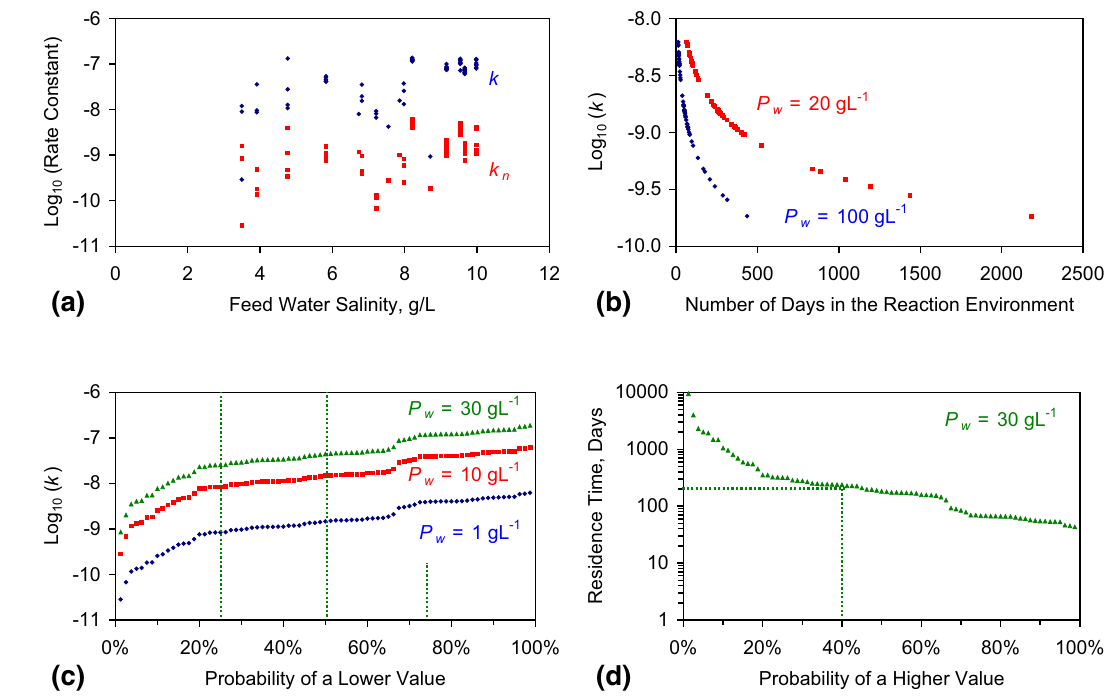
Fig. 3 Catalyst A: rate constants. a k and k of the trials are provided in Antia (2015b). Probability ( P ) calculated n versus feed water salin- by ranking values, where P = rank number/(total number of sam- ity. b k n versus time required to reduce the water salinity by 50%. c k versus probability of a lower value. d Probability versus residence ples + 1): methodology after Antia (1986) time required to achieve a 50% reduction in salinity. Further details